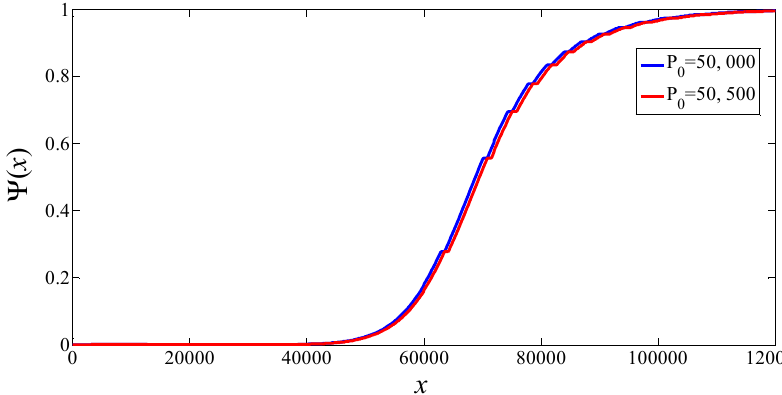
Figure 4. Stability of UPMJ related to the transmission of Ebola virus.